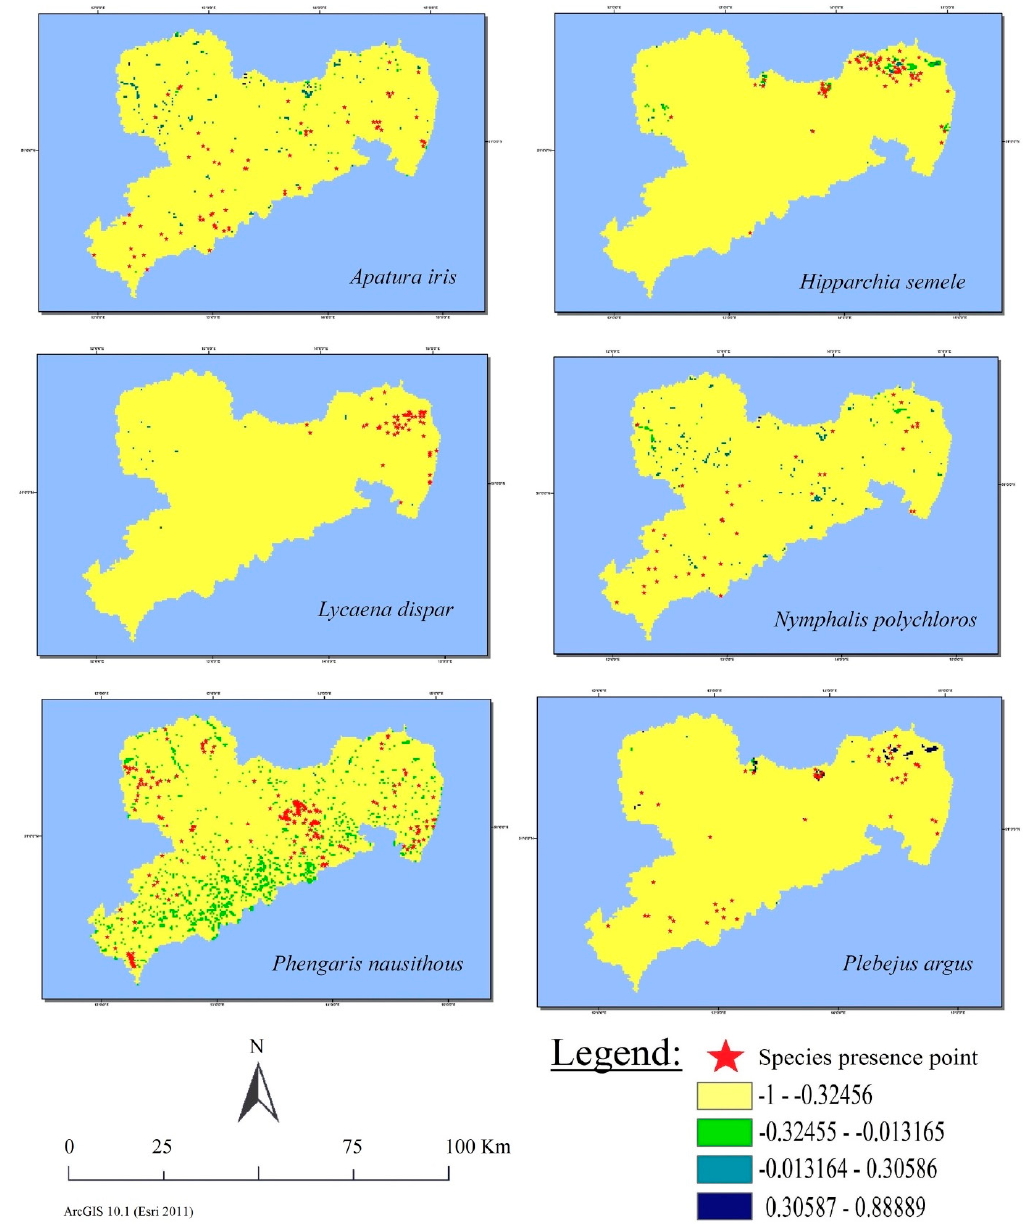
Figure 4. Maps of average habitat suitability based on experts opinions for all six species (HS values towards − 1.0 indicate avoidance while +1.0 represents suitable).